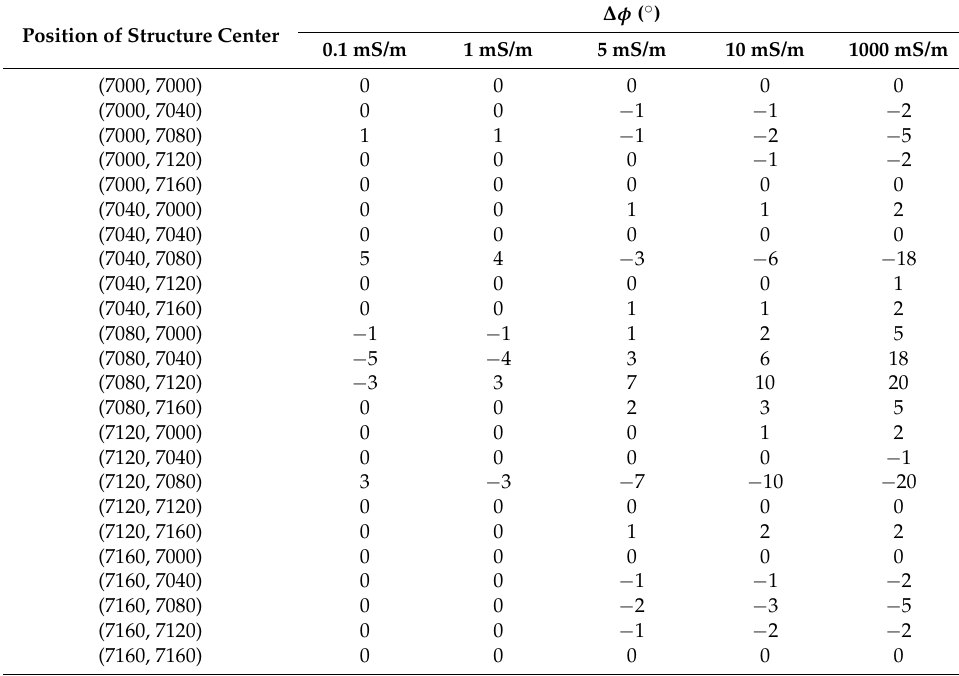
Table 6. Azimuth errors estimated for true azimuth  equal to 26.6 ° (tan −1  = 0.5).